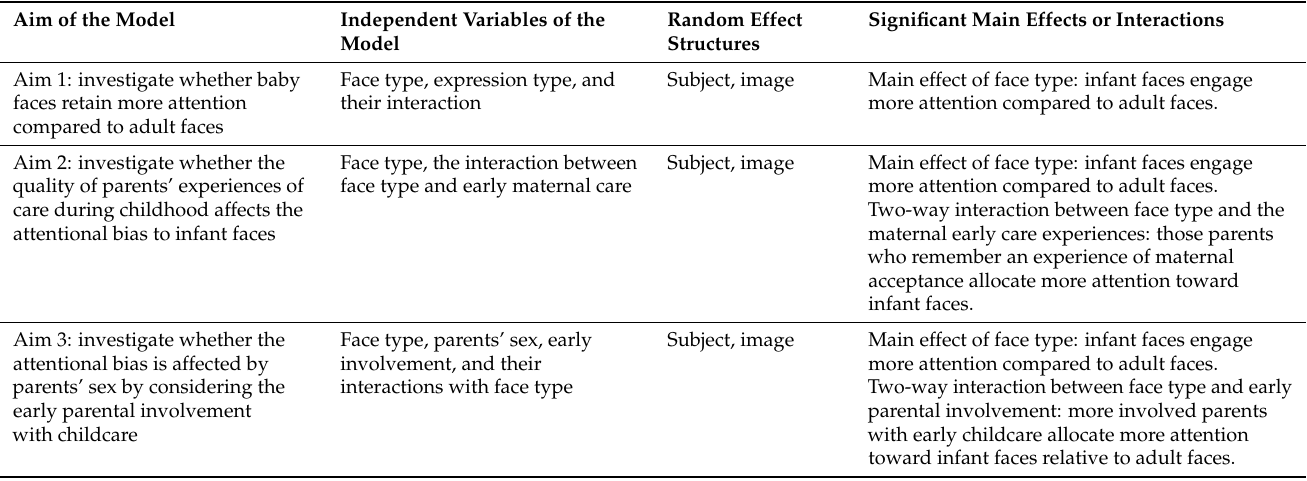
Table 3. An overview of the aims, independent variables, random effect structures, and significant results of the main analyses of the